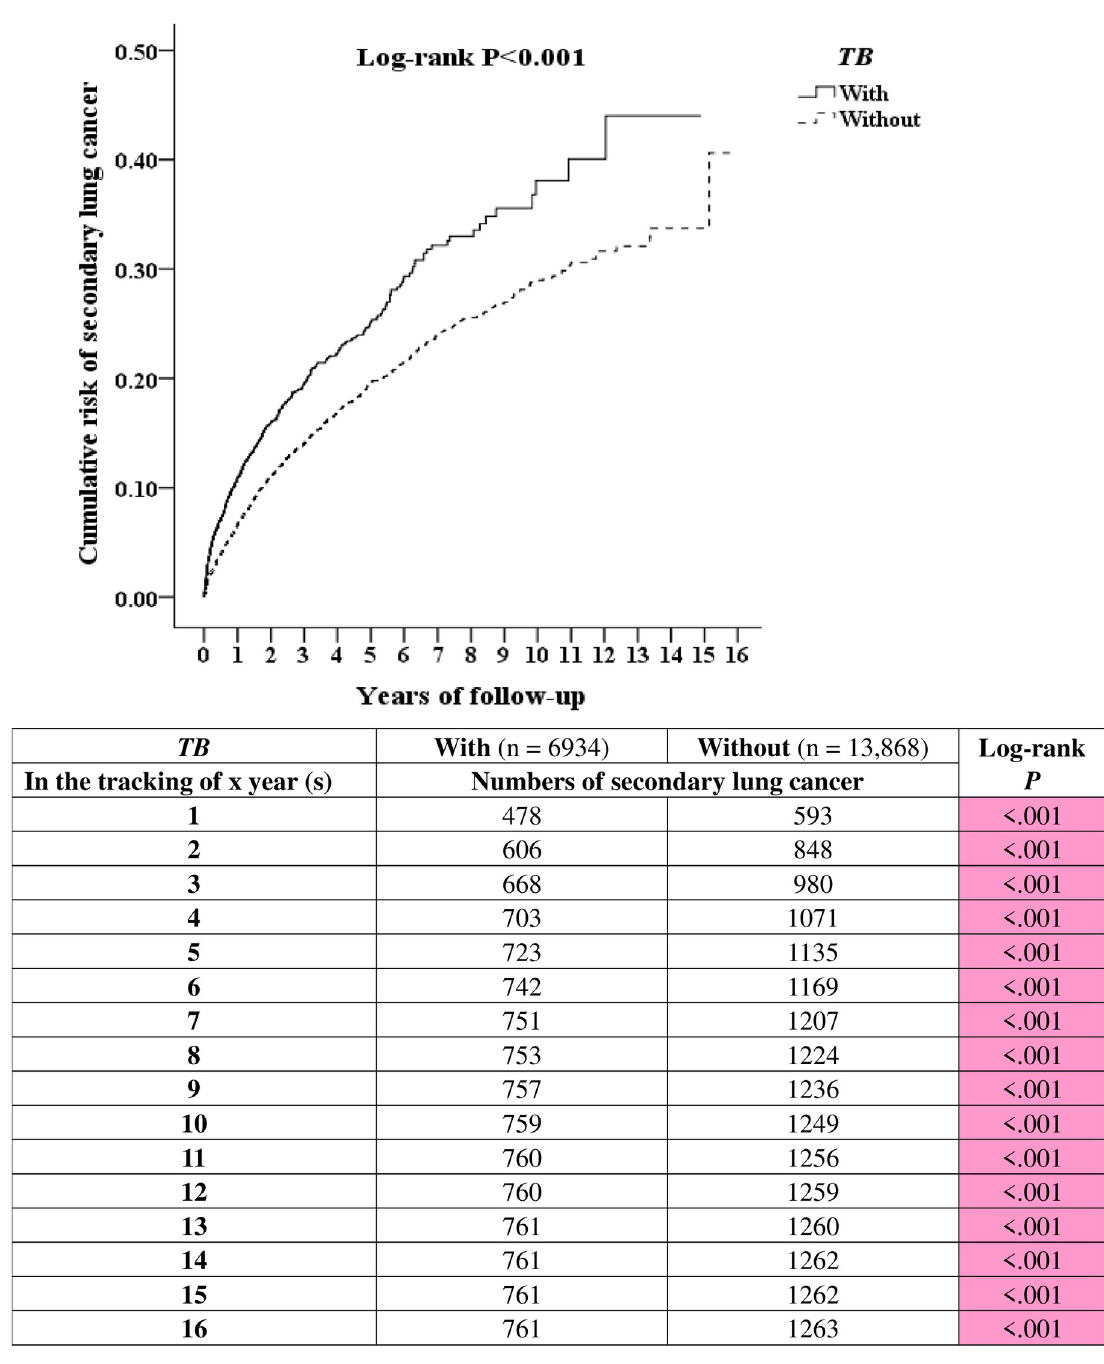
Fig 2. Kaplan-Meier for cumulative risk of secondary lung cancer among primary cancer patients aged 20 and over stratified by TB with the log-rank test.